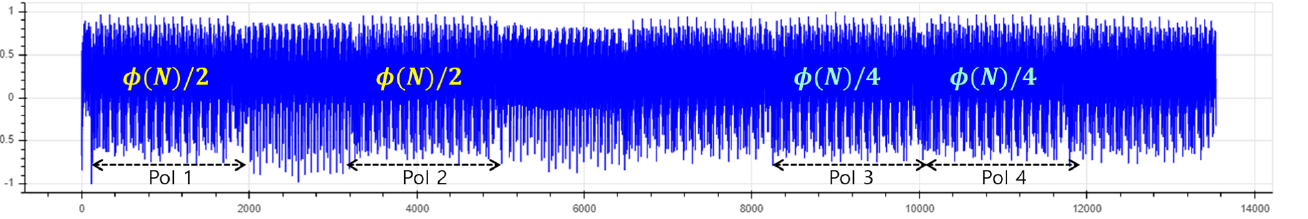
Figure 1. Power trace of protected BEEA with optimization option